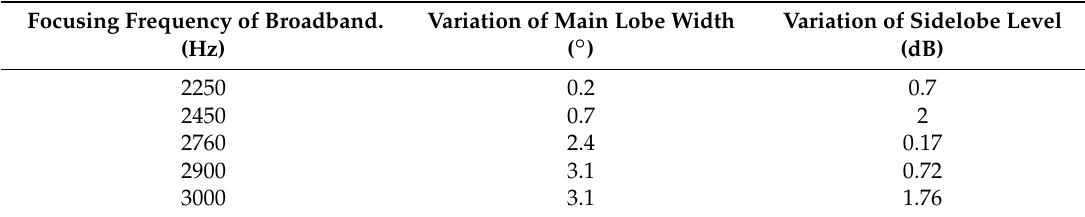
Table 3. Comparison of beamforming parameter change between narrowband and broadband signals. Focusing Frequency of Broadband.